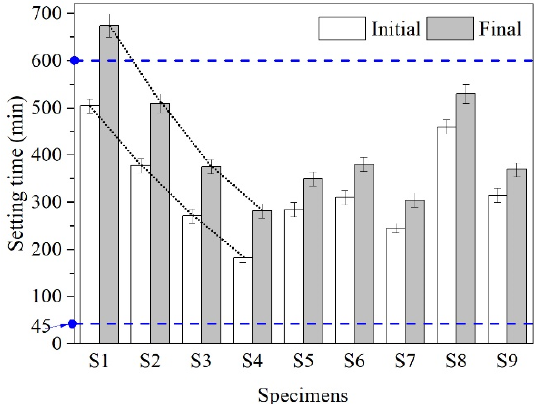
Figure 4. The setting time of AAS specimens: S1–S4, SR (8%, 16%, 24%, 36%)-activated GGBS pastes; S5, Ca(OH) 2 -activated GGBS pastes; S6, Ca(OH) 2 + NaCl- activated GGBS pastes; S7, Ca(OH) 2 + CaCl 2 -activated GGBS pastes; S8, Ca(OH) 2 + CaSO 4 -activated GGBS pastes; S9, and Ca(OH) 2 + CaCO 3 -activated GGBS pastes.